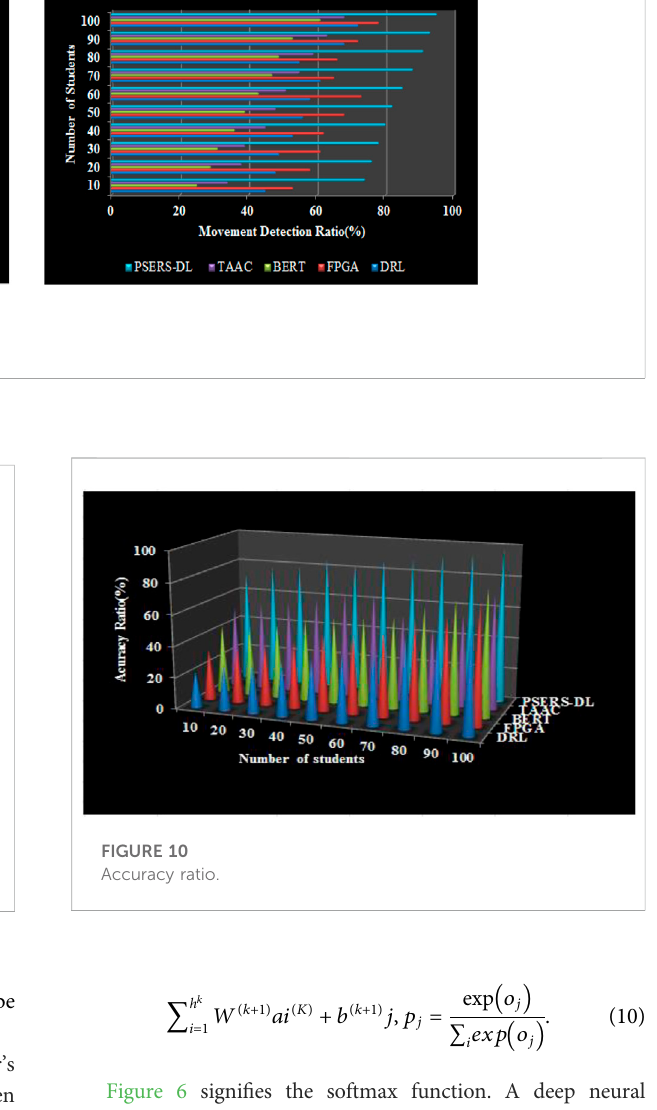
As found in Eq. 11, cross-entropy optimization has been explored, where C indicates the number of training instances and total grades. In addition, the class label is 1 if it is C and 0; otherwise, for the i th training case. Therefore, p ic is the forecast likelihood of class c in the i th course. The proposed PSERS-DL model enhances the accuracy ratio of performance ratio, prediction ratio, increased ef fi ciency ratio, less error rate, low delay time ratio, and high-security rate.